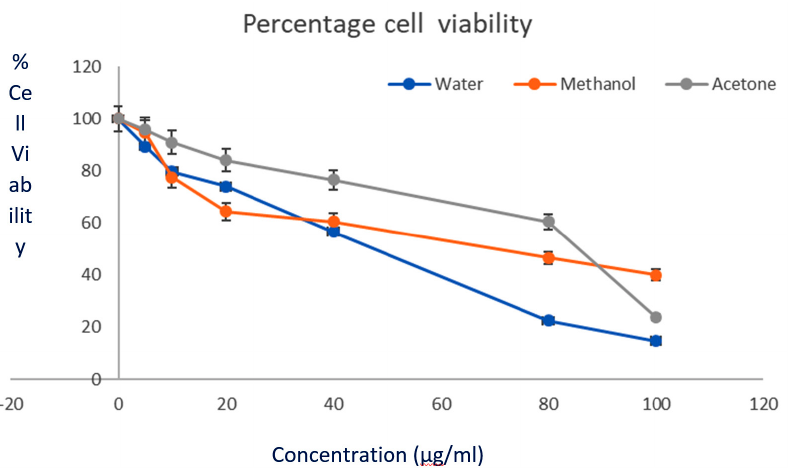
Fig. 3. Cytotoxic activity of L. nobilis extracts against HeLa cell line (MTT assay). The graph shows the % cell viability. All data are expressed as mean ± standard deviation (n =